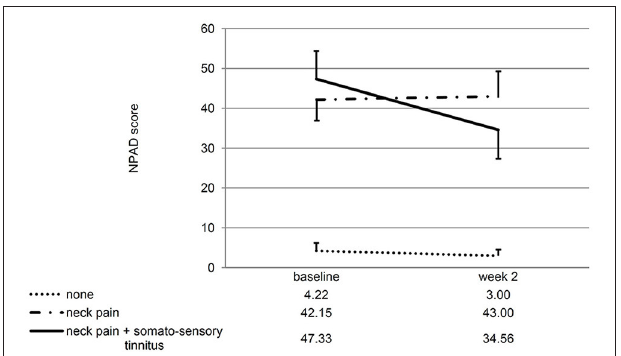
FIGURE 4 | Line chart showing the NPAD score at baseline and week 2 for all three subgroups of patients. Error bars represent standard errors. The NPAD change of patients with both somatosensory tinnitus and neck pain differed significantly from the NPAD change of patients with neither condition. The difference to the change of patients with neck pain only was marginally significant.